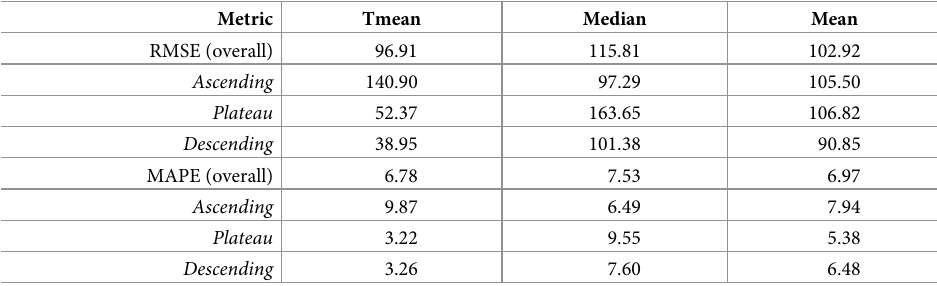
Table 3. Error metrics per combination across